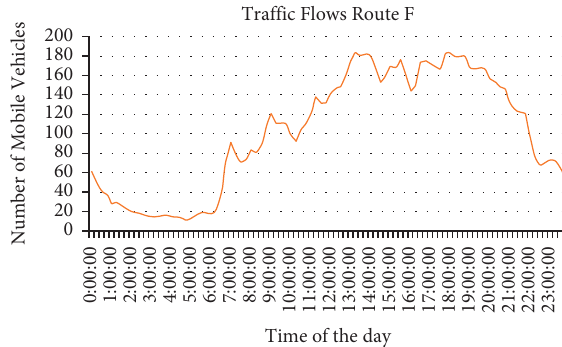
Figure 13: Traffic flow: route